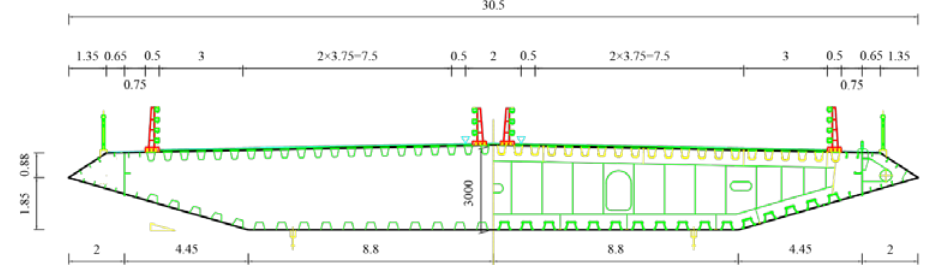
Figure 2. Standard cross-section of main beam (unit: m).